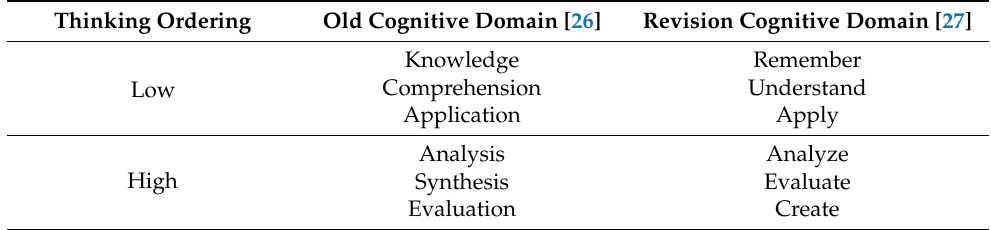
Table 1. Comparison of the old and new cognitive